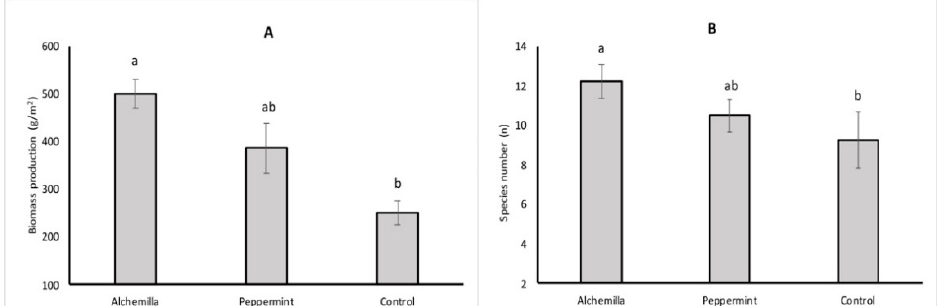
Figure 1. Effect of living mulching species on above ground dry biomass ( A ), and species number ( B ). Bars represent the SEM. Bars with different letters are significantly different at p ≤ 0.05 (Tukey–Kramer HSD test).